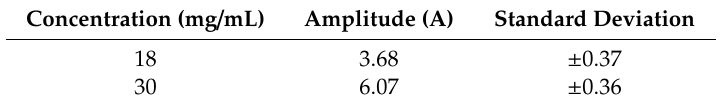
Table 1. Fitting parameters in the diffusion-limited aggregation law, with